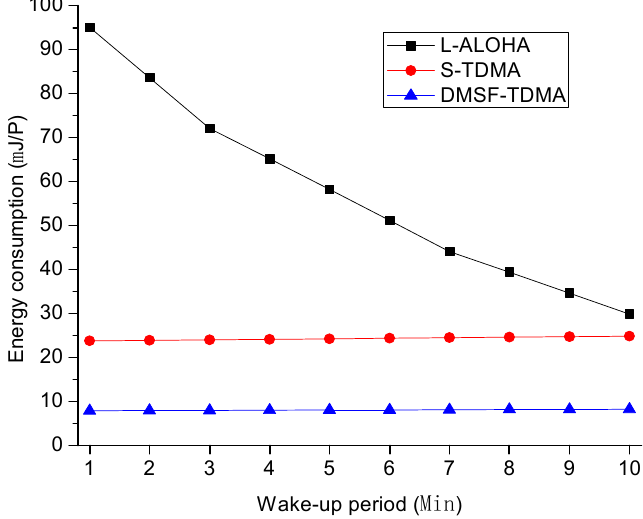
Figure 16. Average energy consumption with different wake-up periods.